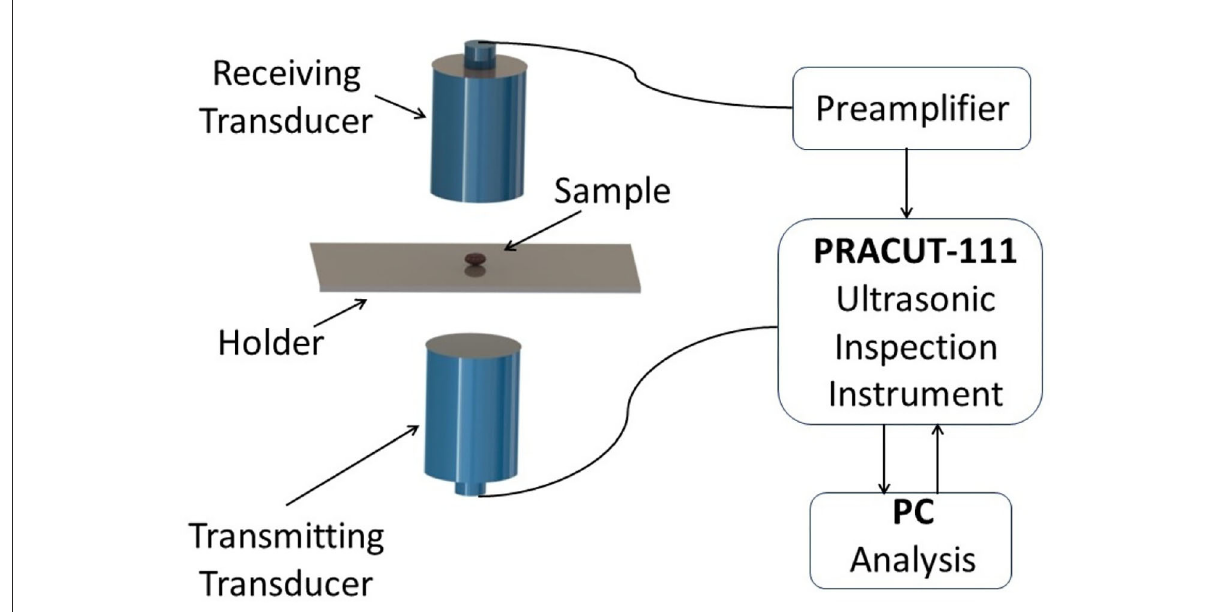
FIGURE2 Scheme of air-coupled ultrasonic inspection system set-up.